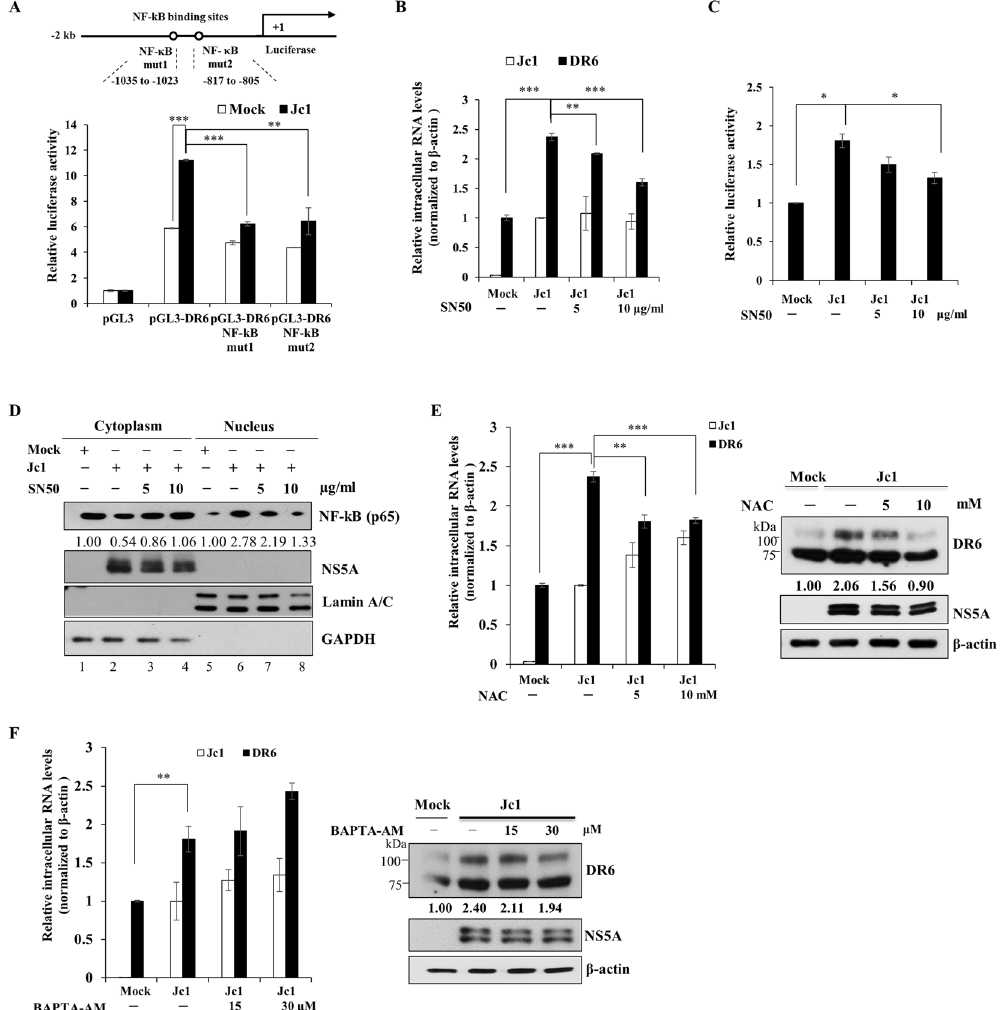
Figure 2. HCV promotes DR6 expression via ROS-mediated NF- κ B activation. ( A ) (Upper panel) Shematic diagram of DR6-luc promoter construct with mutations in NF- κ B binding sites. (Lower panel) Huh7.5 cells were either mock-infected or infected with HCV Jc1 for 4 h. At 48 h postinfection, cells were transfected with pGL3 vector, wild-type or mutants of DR6 promoter. At 48 h after transfection, cells were harvested and luciferase activities were determined. Data from two independent experiments were quantified. The asterisks indicate significant differences ( * P < 0.05, * * P < 0.01; ** * P < 0.001) from the value for the control. ( B ) Huh7.5 cells were either mock-infected or infected with HCV Jc1 for 4 h. At 48 h postinfection, cells were either left untreated or treated with increasing amounts of SN50. At 48 h after inhibitor treatment, mRNA levels of DR6 were determined by qRT-PCR. ( C ) Huh7.5 cells were infected with Jc1 for 4 h. At 48 h postinfection, cells were either left untreated or treated with increasing amounts of SN50. At 48 h after inhibitor treatment, DR6 promoter activities were analyzed. ( D ) Huh7.5 cells were either mock-infected or infected with Jc1 for 4 h. At 48 h postinfection, cells were either left untreated or treated with increasing amounts of SN50. At 48 h after inhibitor treatment, cytosolic and nuclear fractions were subjected to immunoblot analysis to determine NF- κ B level. GAPDH and Lamin A/C were used as cytoplasmic and nuclear marker, respectively. ( E ) Huh7.5 cells were either mock-infected or infected with Jc1 for 72 h. Cells were either left untreated or treated with increasing amounts of antioxidant agent NAC. At 24 h after NAC treatment, both mRNA (left panel) and protein (right panel) levels of DR6 were analyzed by qRT-PCR and immunoblot analysis, respectively. ( F ) Huh7.5 cells were either mock-infected or infected with Jc1 for 72 h. Cells were either left untreated or treated with increasing amounts of intracellular Ca 2 + chelator, BAPTA-AM. At 24 h after BAPTA-AM treatment, both mRNA (left panel) and protein (right panel) levels of DR6 were analyzed by qRT-PCR and immunoblot analysis, respectively. Protein band intensities were analyzed by using